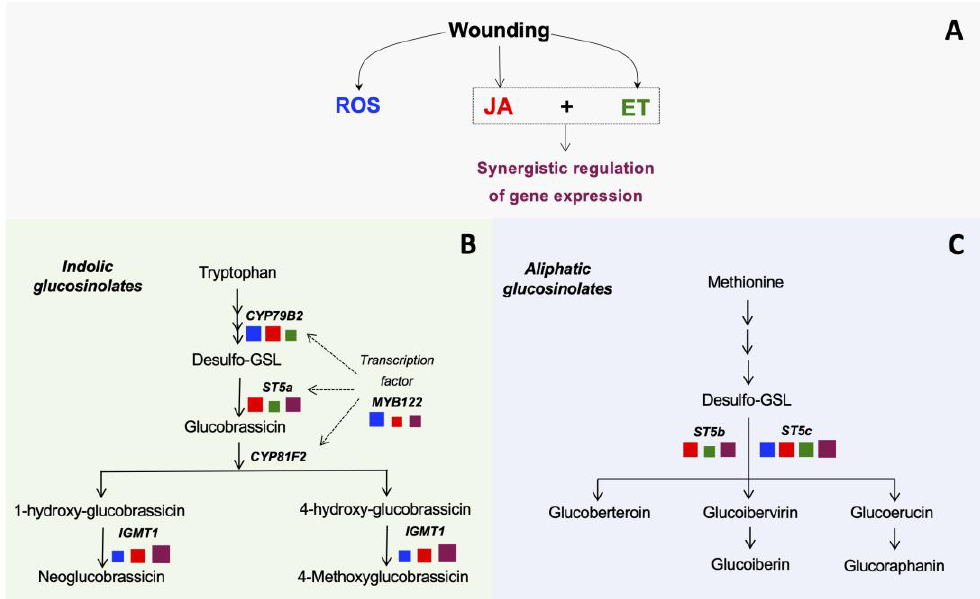
Figure 4. A scheme summarizing the role of stress-signaling molecules on the wound-induced activation of glucosinolate biosynthetic-related genes in broccoli. The model is focused on the role of jasmonic acid (JA), reactive oxygen species (ROS), and ethylene (ET), which are the signaling molecules herein evaluated. The production of signaling molecules occurs after wounding stress ( A ), which further upregulates the expression of genes involved in the biosynthesis of indolic ( B ) and aliphatic ( C ) glucosinolates. The color of the squares next to the gene name indicates the signaling molecule that upregulates its wound-induced gene expression. Blue, red, and green squares indicate upregulation by ROS, JA, and ET, respectively. Maroon squares indicate synergistic upregulation of the gene by JA and ET. The square size indicates the impact level of each signaling molecule on the wound-induced activation of the gene.